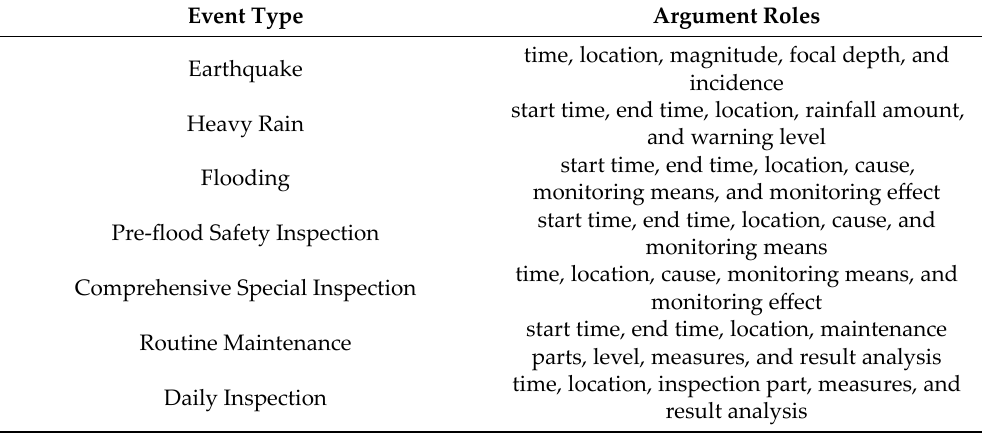
Table 2. Event types and corresponding event arguments in the dam safety operation log dataset.